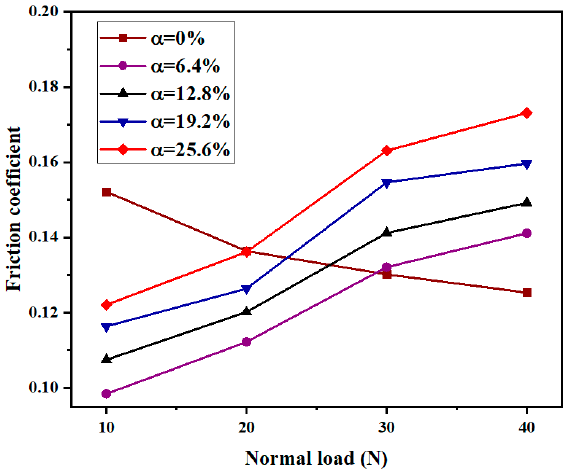
Figure 6. Variation of friction coefficient with normal load.